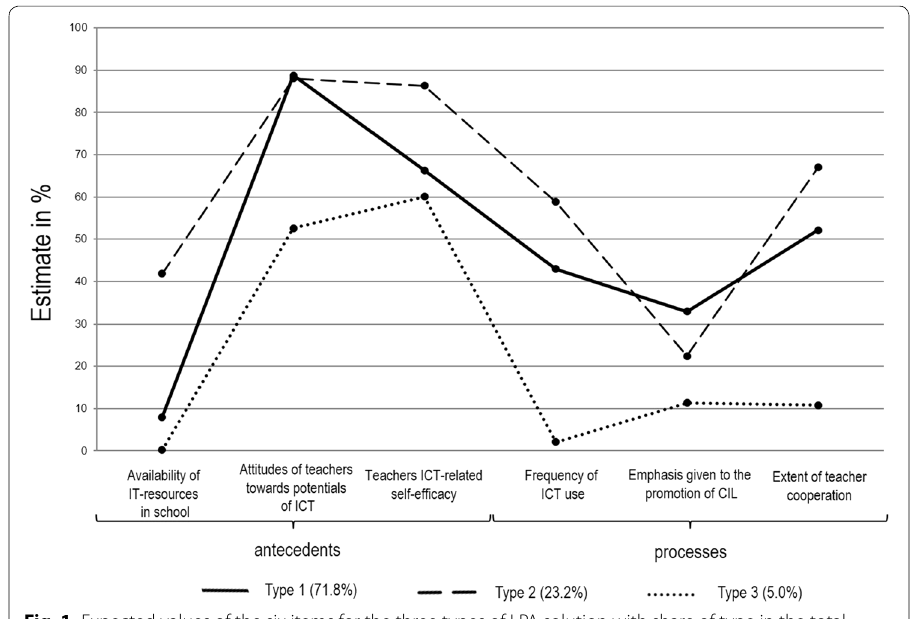
Fig. 1 Expected values of the six items for the three types of LPA solution with share of type in the total sample examined (N 107 =